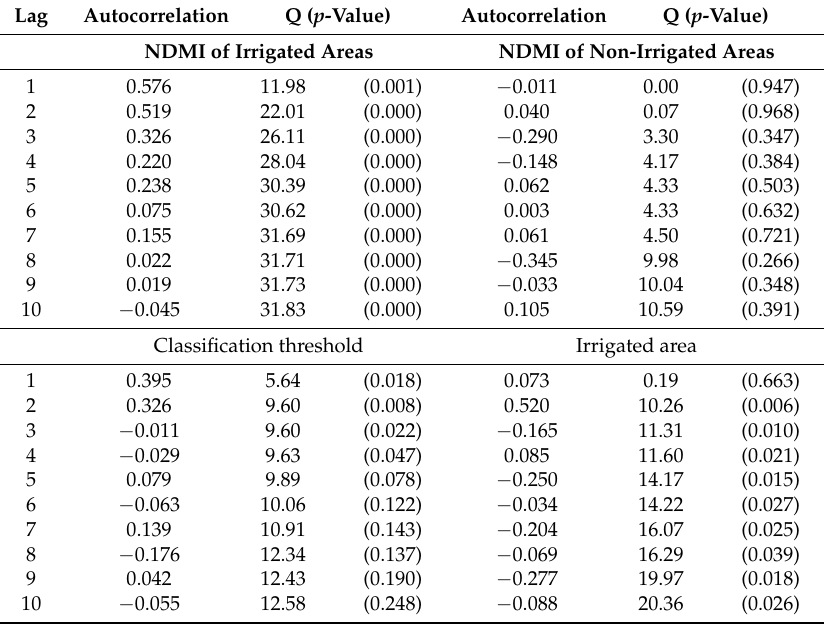
Table A1. Autocorrelation and Q-statistics, time series in Figure